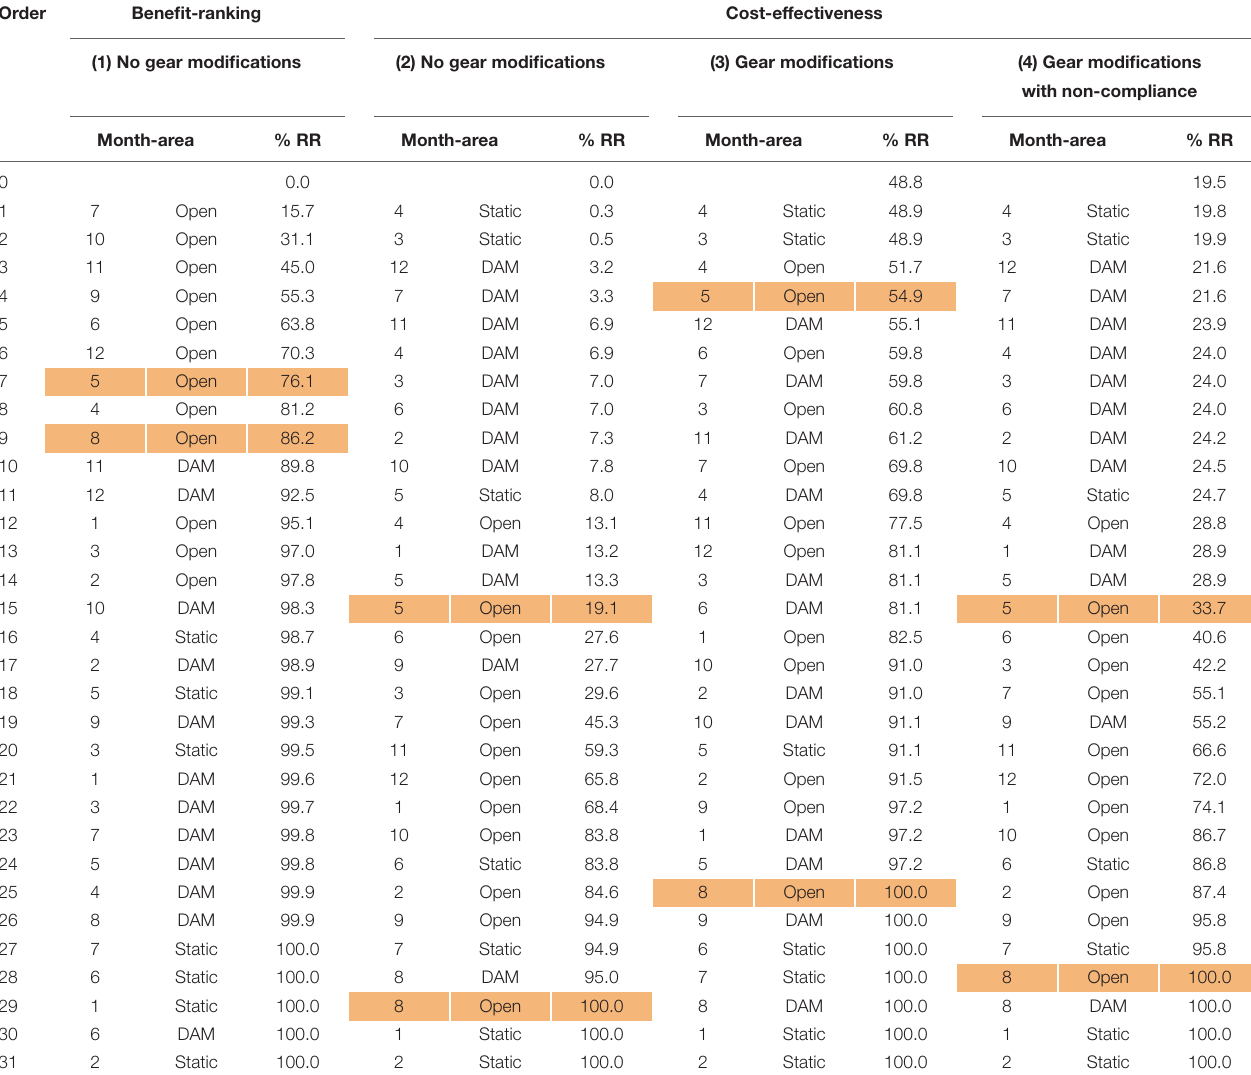
TABLE 6 | Optimization results showing the solution paths with the cumulative percent reduction in risk (% RR) moving from no change (i.e., status quo, R = 0%) to a complete reduction in risk (i.e., complete closure, R = 100%) for scenarios 1–4. Order Benefit-ranking